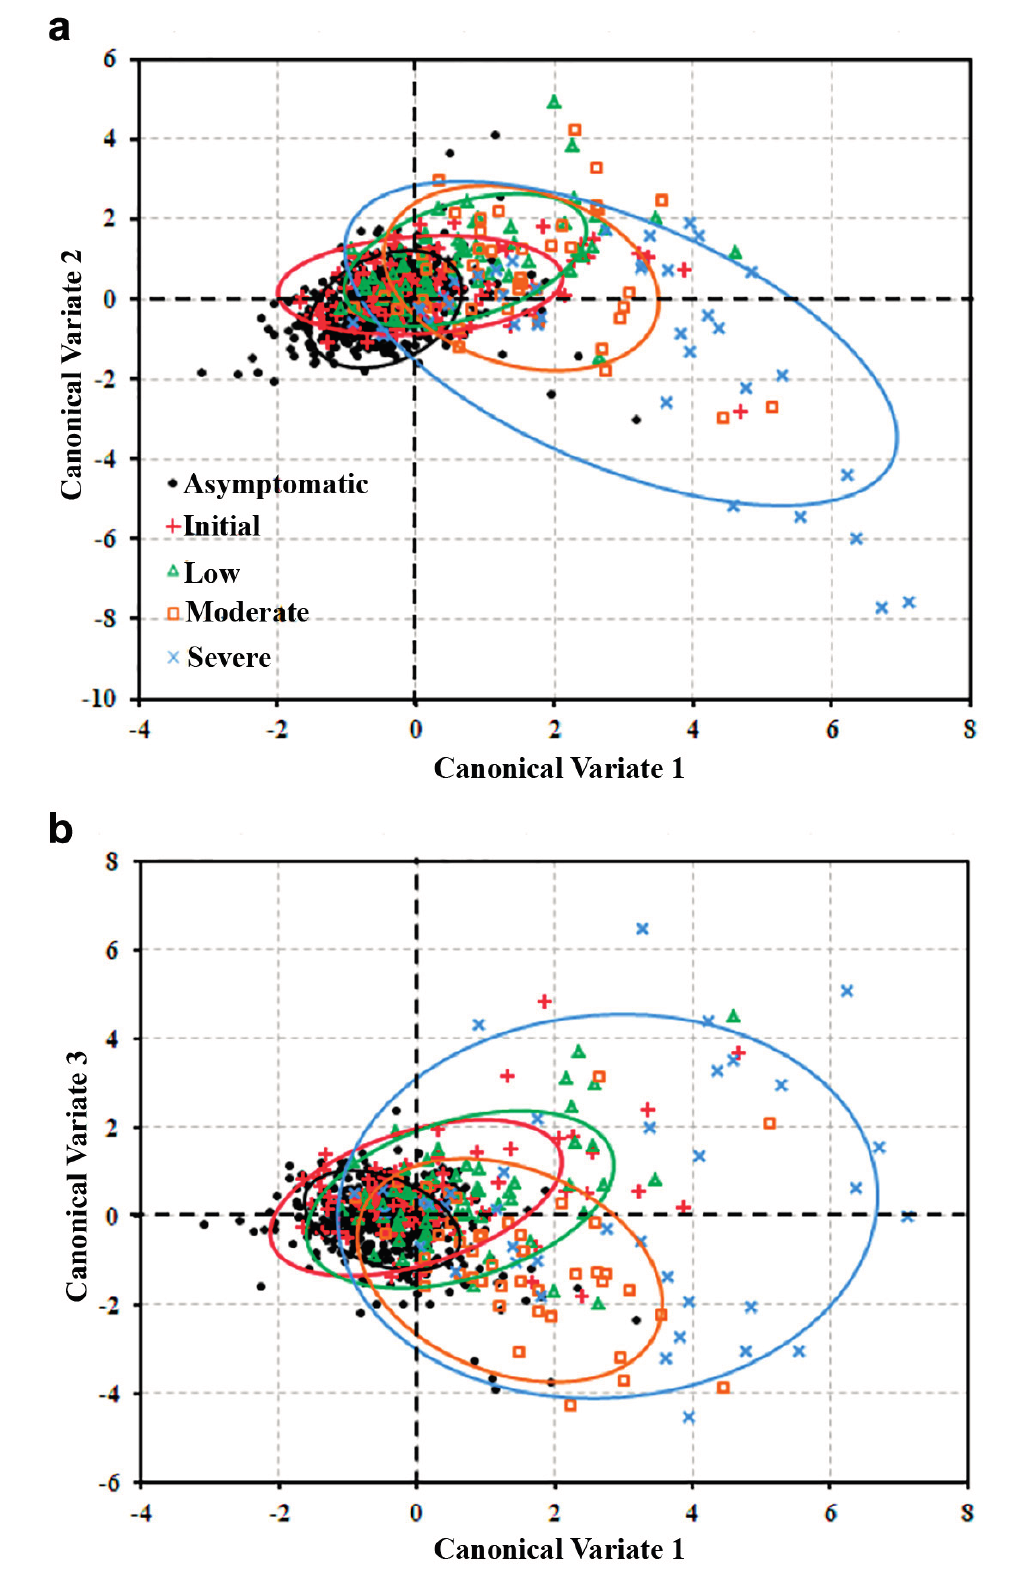
Figure 5. Classification of 756 olive trees assessed in Ecija into five Verticillium wilt severity classes based on ( a ) the first and second canonical variates and ( b ) the first and third canonical variates, from the canonical discriminant